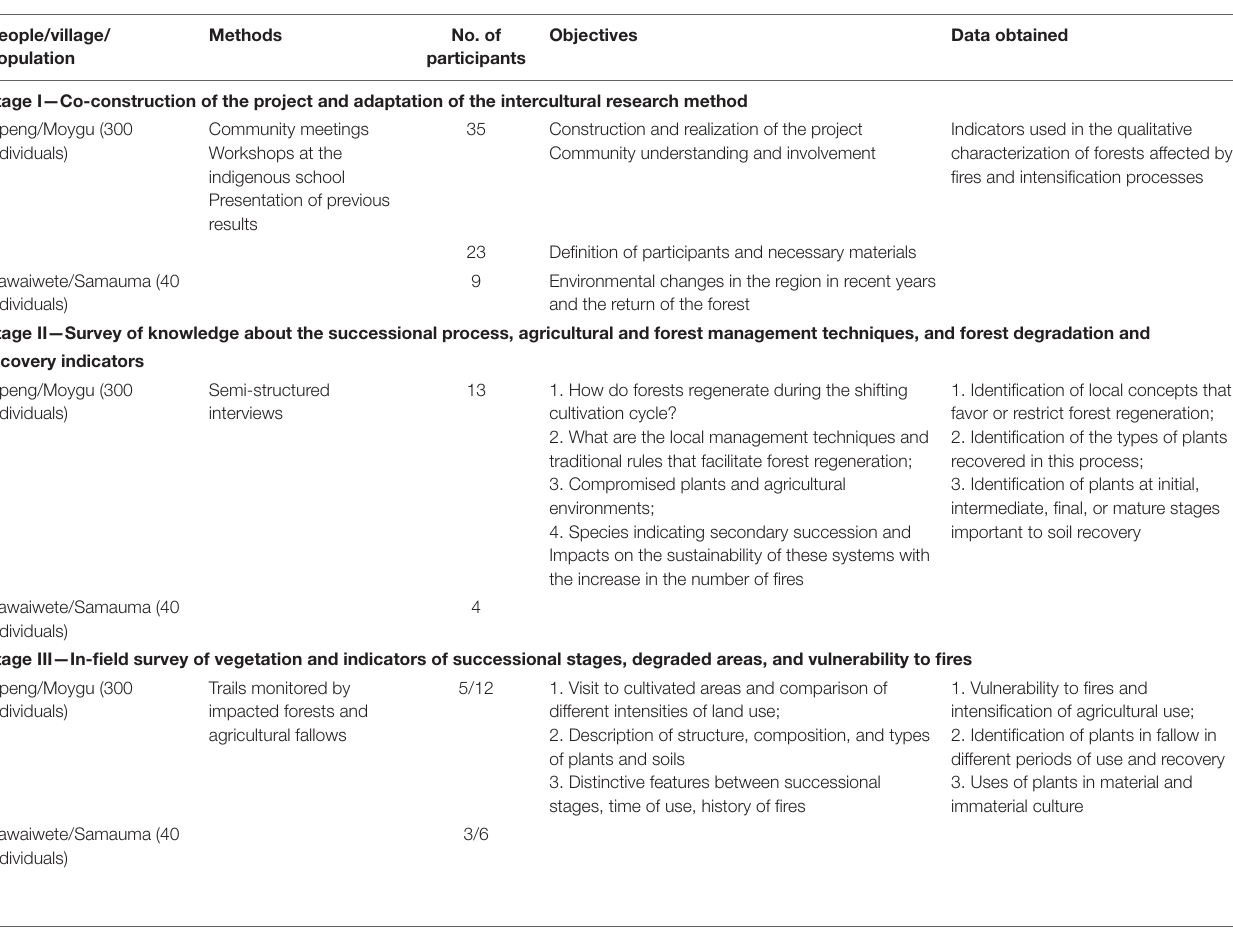
TABLE 1 | Methodological steps of the